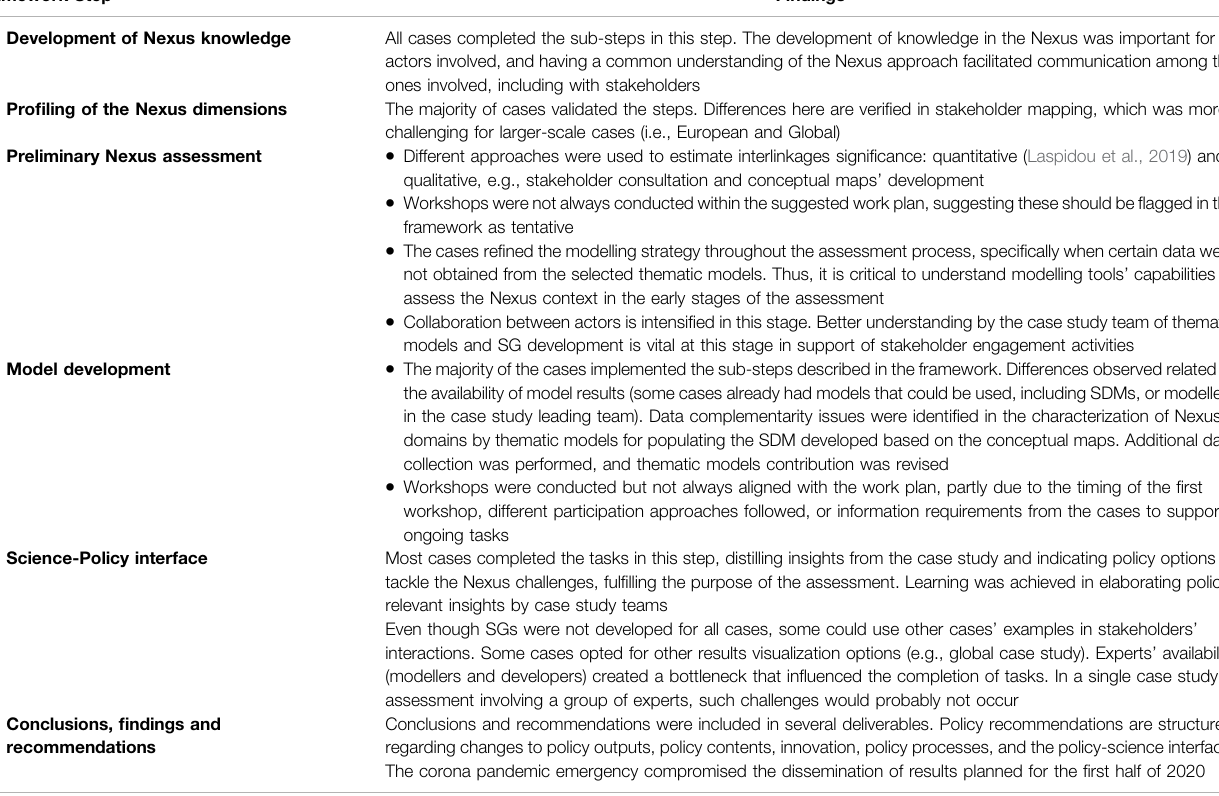
TABLE 3 | Analysis of the application of framework steps in case studies considering the activities reported in Deliverable 5.5 (Brouwer and Fournier, 2020b). Framework Step